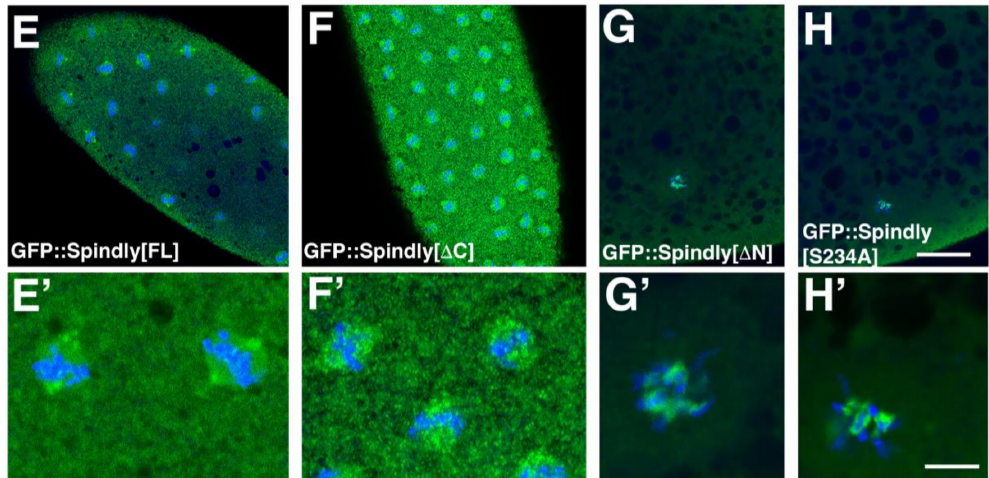
Figure 5. Domain-function analyses of Spindly in the embryo. ( A ) Larval hatching rates in